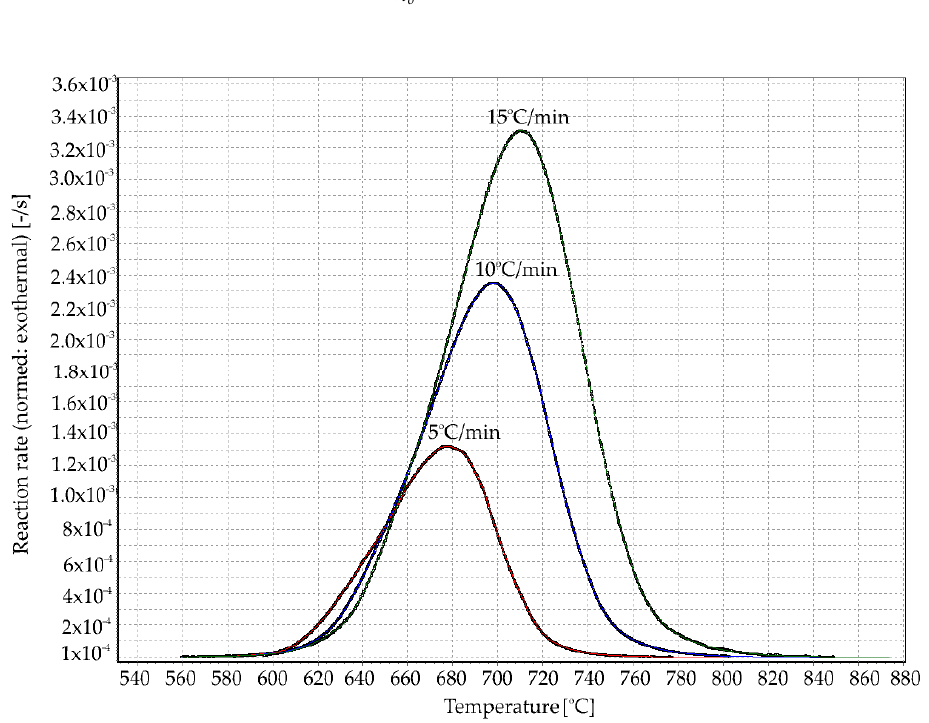
Figure 3. Conversion rates as a function of the temperature at heating rates β i = 5, 10, and 15 ◦ C /